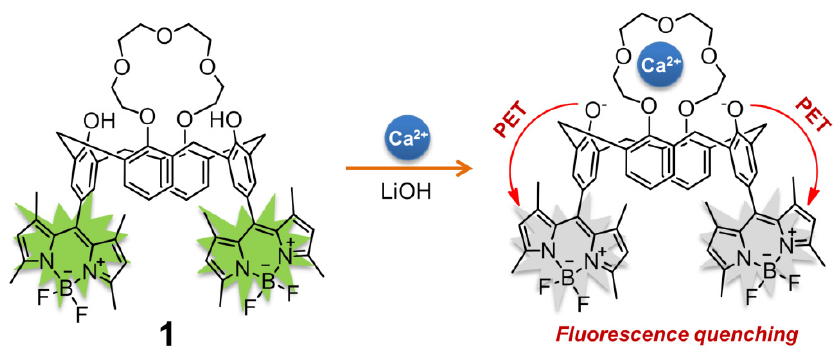
Figure 3. BODIPY-functionalized calix[4]arene 1 for Ca 2+ .